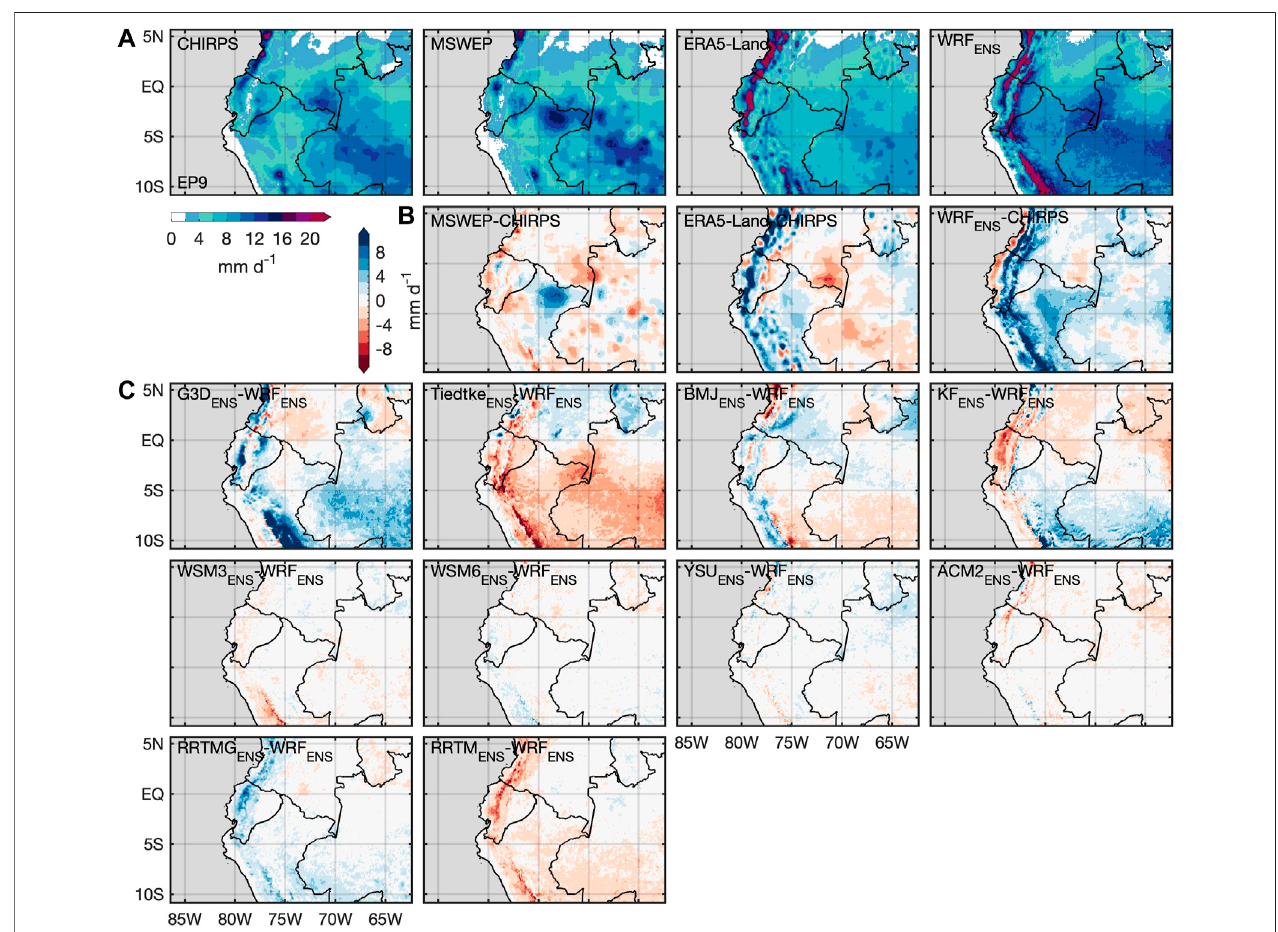
FIGURE 3 | (A) Observed and simulated mean precipitation in JFM 2007 of CHIRPS, MSWEP, ERA5-Land and WRF ensemble median (WRF ENS ) over EP9. (B) Bias of MSWEP, ERA5-Land and WRF ENS against CHIRPS. (C) Deviation of the parameterization sub-ensemble median from WRF ENS .